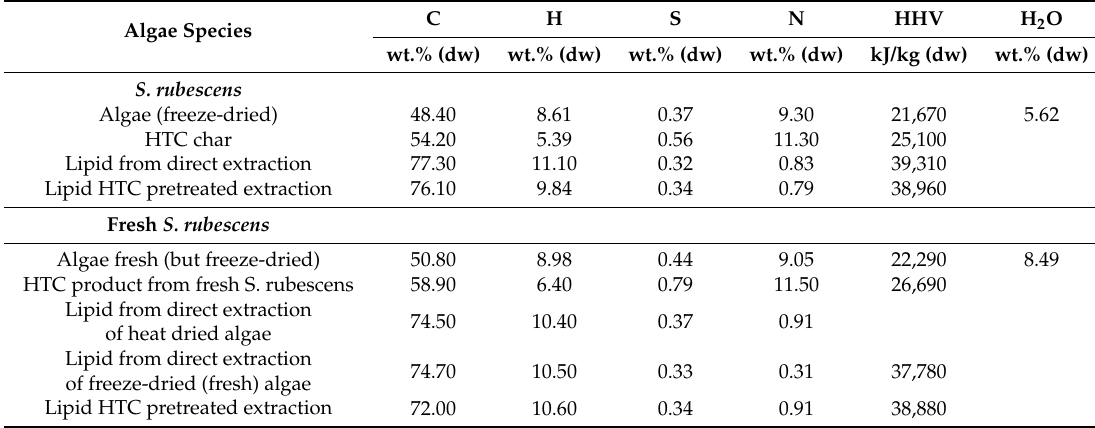
Table 1. Elemental composition of the algae species and